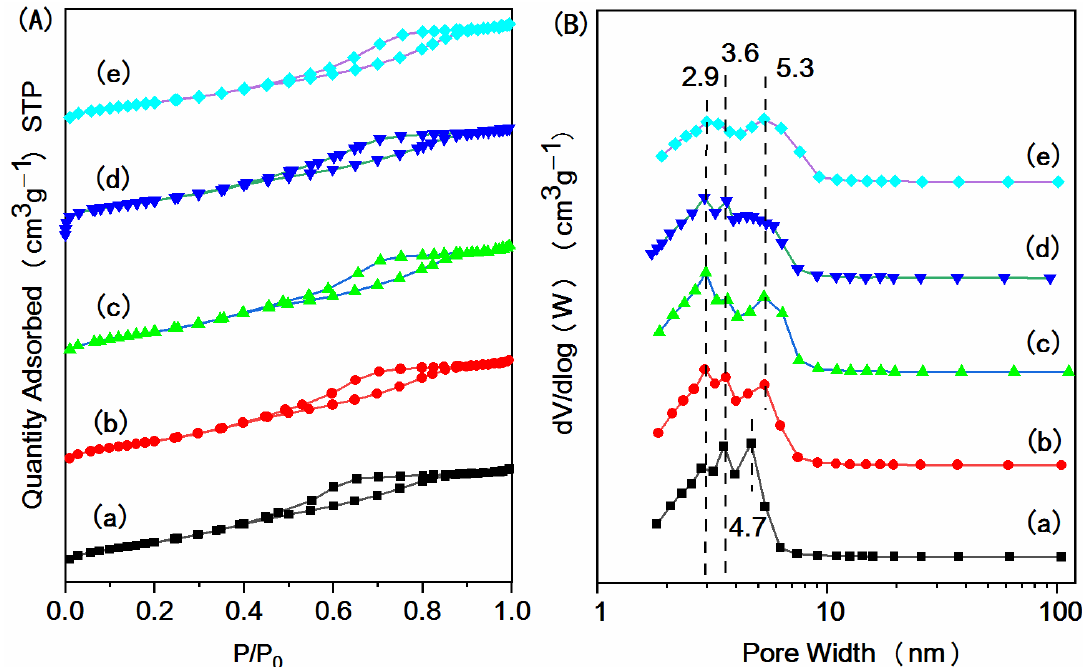
Figure 1. N 2 adsorption – desorption isotherms ( A ) and pore size distribution curves calculated by BJH equation in desorption branch ( B ) of the calcined xE-Cu/SiO 2 samples. (a) Cu/SiO 2 , (b) 0.04E-Cu/SiO 2 , (c) 0.08E-Cu/SiO 2 , (d) 0.12E-Cu/SiO 2 , (e) 0.3E-Cu/SiO 2 .